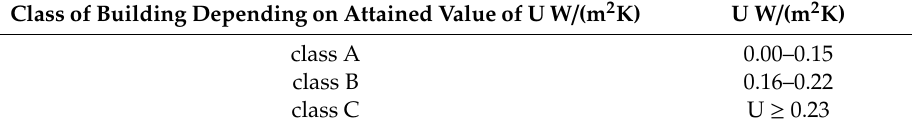
Table 3. Classes of thermally retrofitted historic buildings depending on the thermal transmittance U for external walls